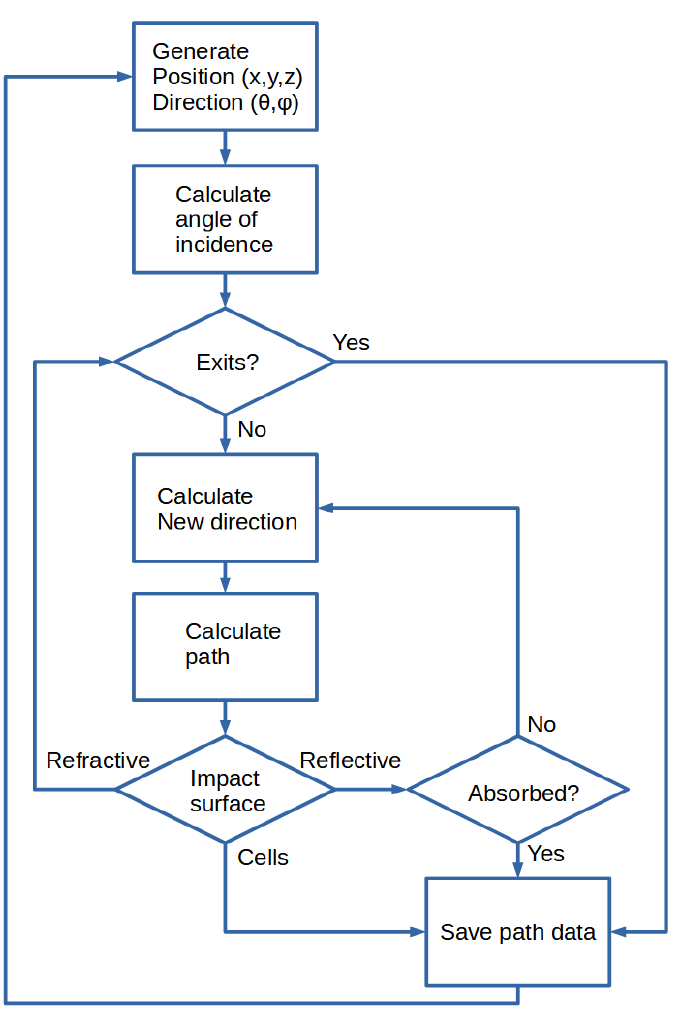
Figure 2. Scheme and concept of the presented Montecarlo simulation model.